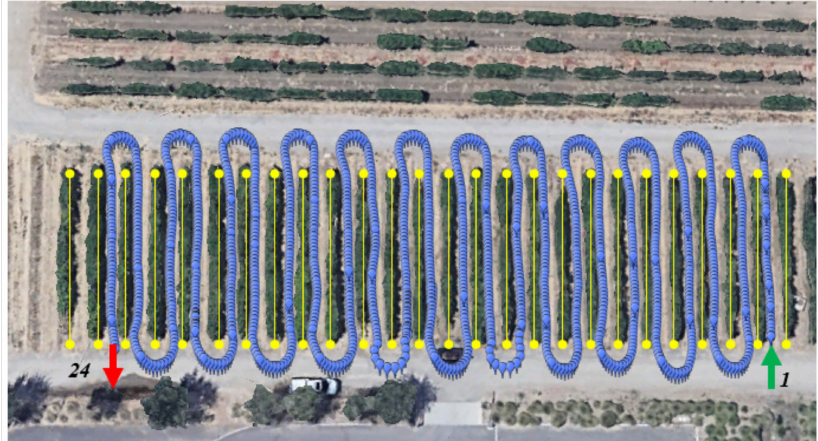
Figure 11. The map of the tree rows (yellow lines) and an example trace of the robot path (blue points represent RTK-GPS positions) during an